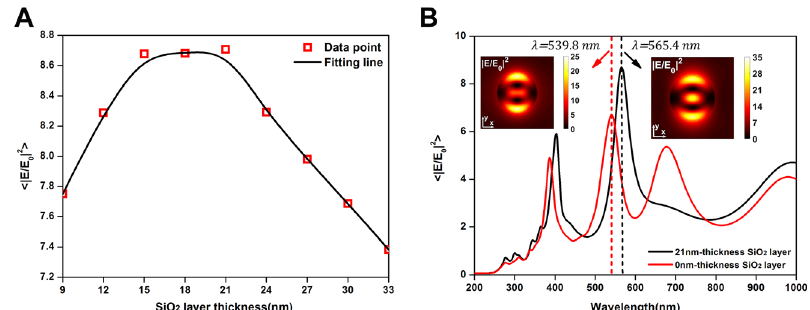
Figure 3: Optimization of the spacer-layer thickness. (Color online) (A)